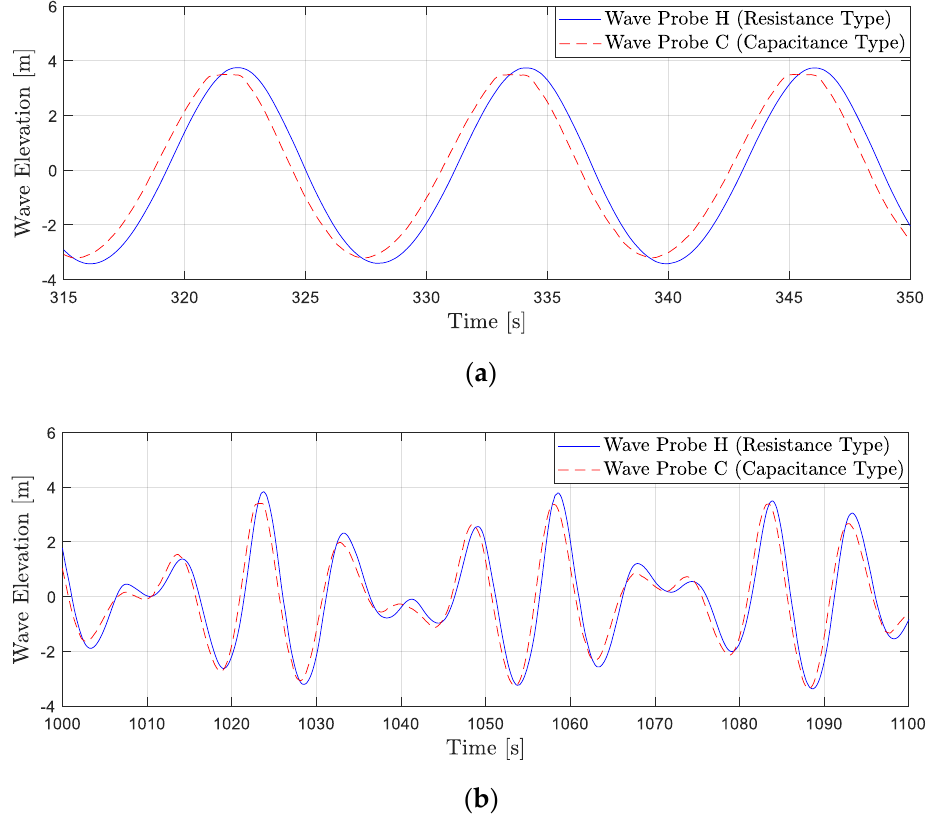
Figure 9. Comparison of wave measurements during wave calibration from the resistance − type probe, Probe H, and the capacitance − type probe, Probe C, of ( a ) regular wave R1 and ( b ) bichromatic wave B1. The wave elevation is at full scale.